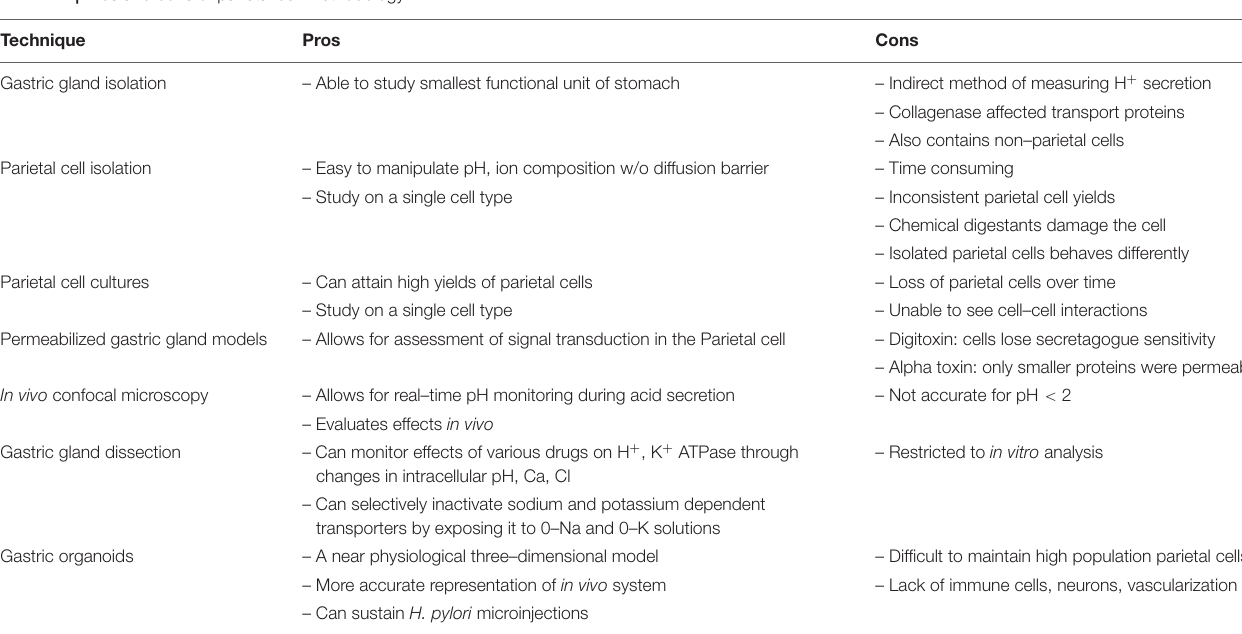
FIGURE 3 | Key Events and Studies Involving the Parietal Cell and Gastric Acid Production. TABLE 1 | Pros and cons of parietal cell